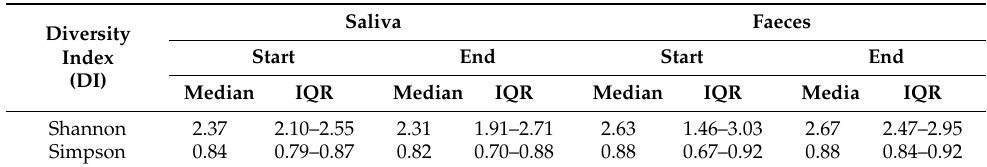
Table 3. Microbial community profile expressed as diversity index (DI) in in vivo samples (n = 20) before and after intake of the fermented quinoa-based